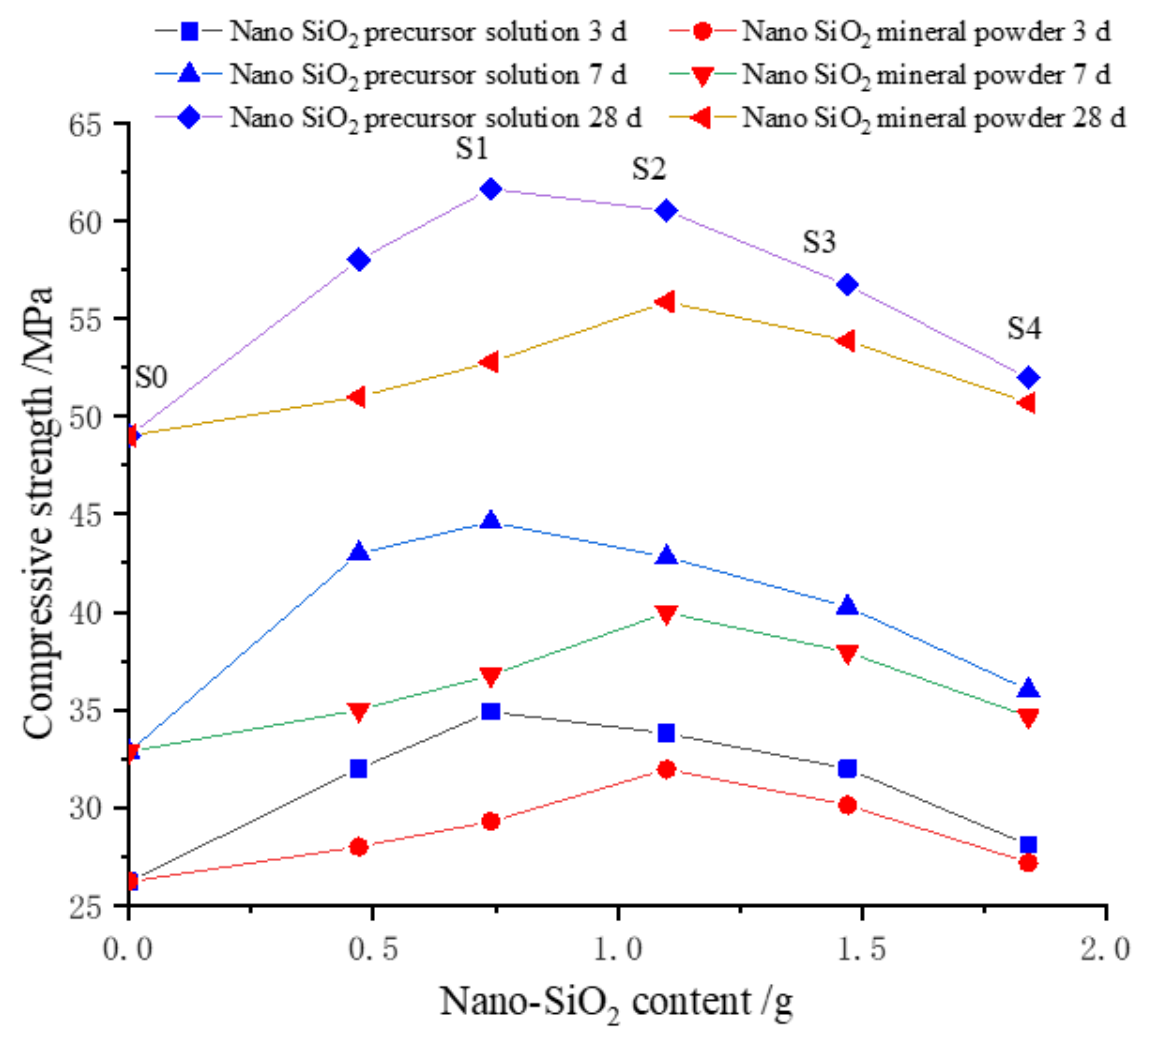
Figure 2. Effect of nano-SiO 2 content on compressive strength of cement-based materials.